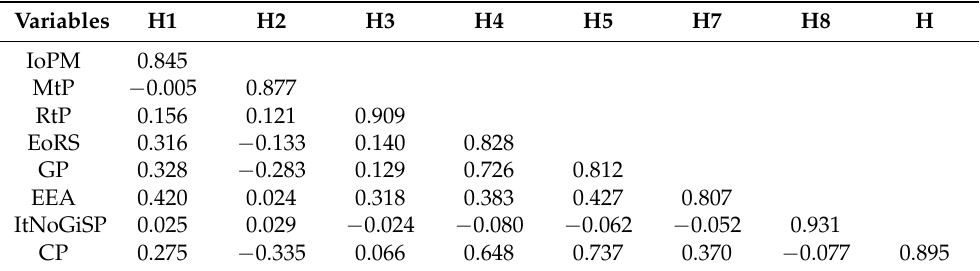
Table 5. Average Variance Extracted (AVE) square root and factor correlation